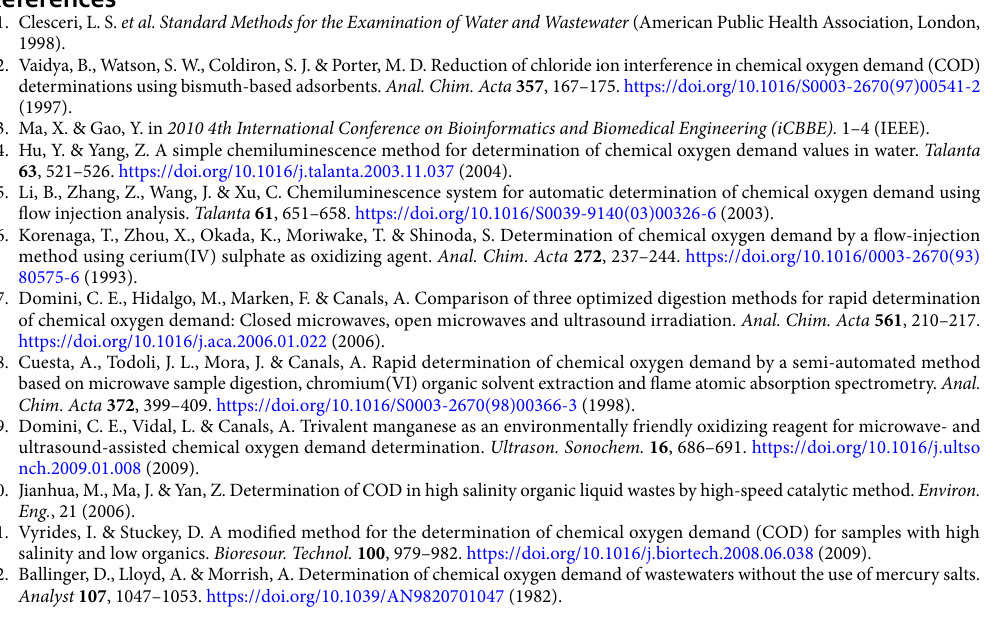
use of resin@P-Ag 2 O in terms of dosage was also proposed base on the salinity of the water sample. This study opens a new way in the application of nanomaterial for chloride adsorption to improve the accuracy of COD measurement for high salinity water and wastewater.